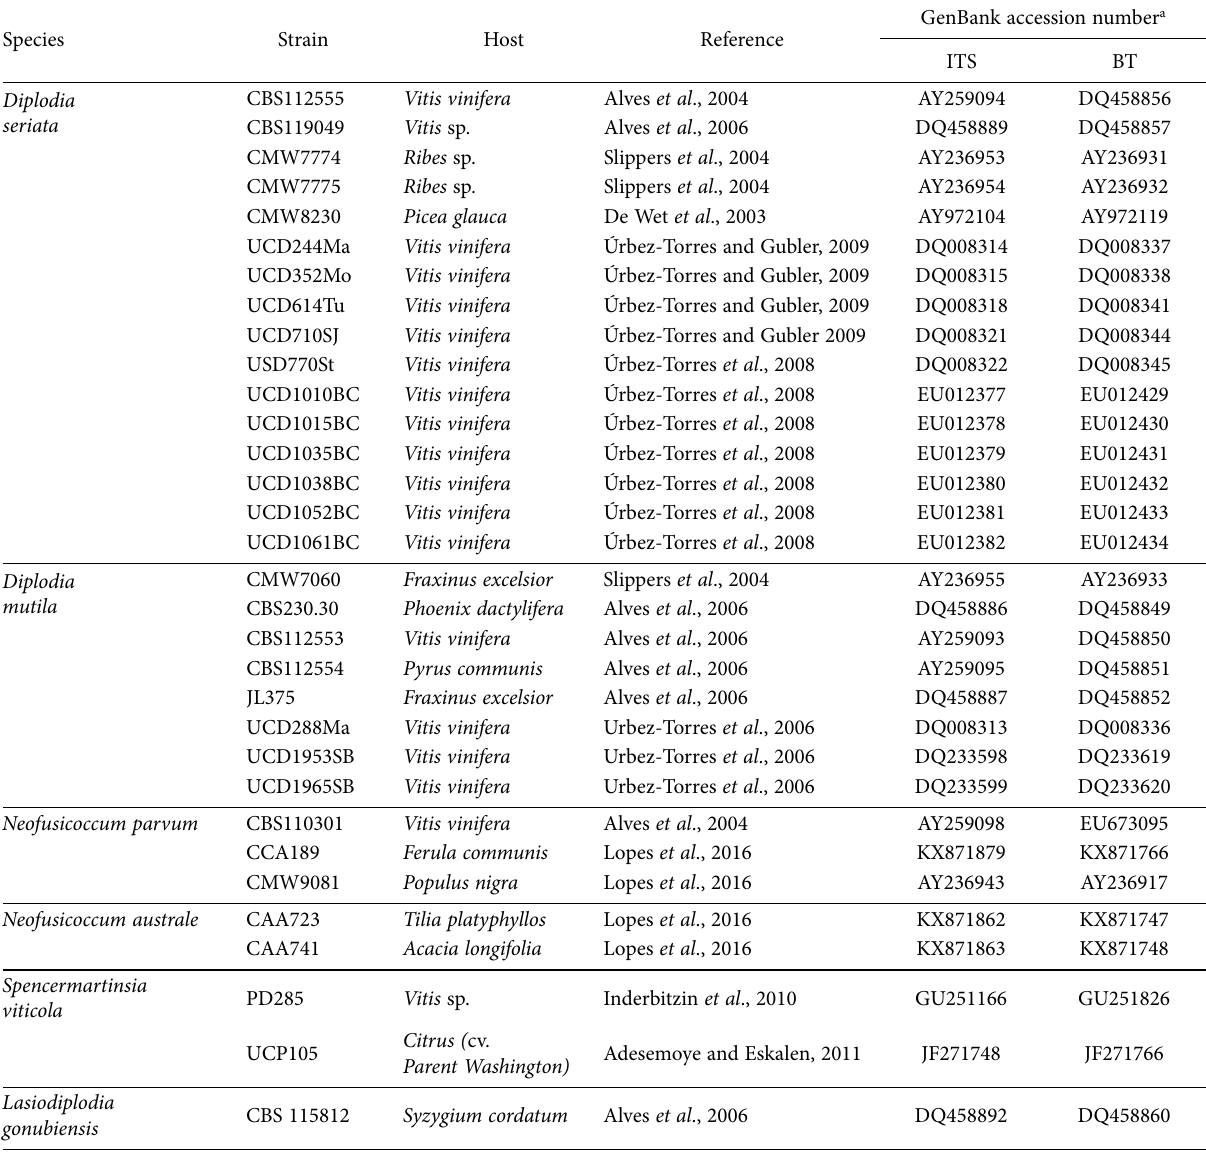
Table 2. Isolates of Diplodia seriata , D. mutila , Neofusicoccum parvum , N. australe , and Spencermartinsia viticola obtained from the Gen- Bank Database included in this study for phylogenetic